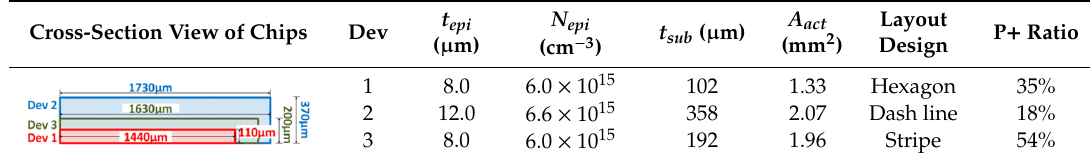
Table 2. Device structural parameters and layout designs.